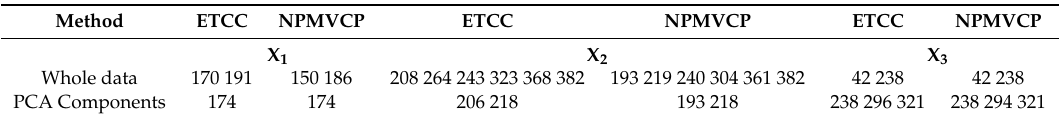
Table 5. Change point detection by energy test-based control chart (ETCC) and nonparametric multivariate change point (NPMVCP) of PCA with simulated multivariate data.